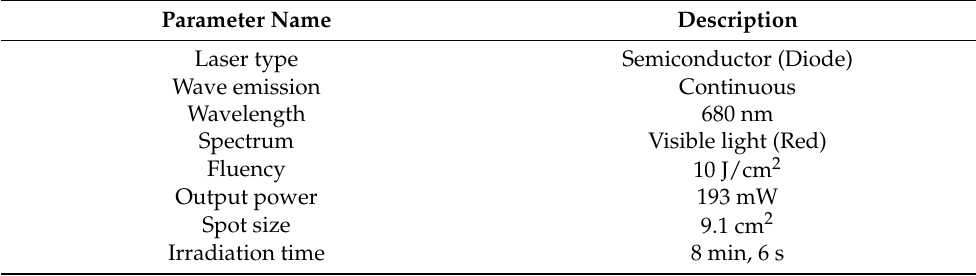
Table 1. Laser parameters employed in ZnPcS 4 -mediated